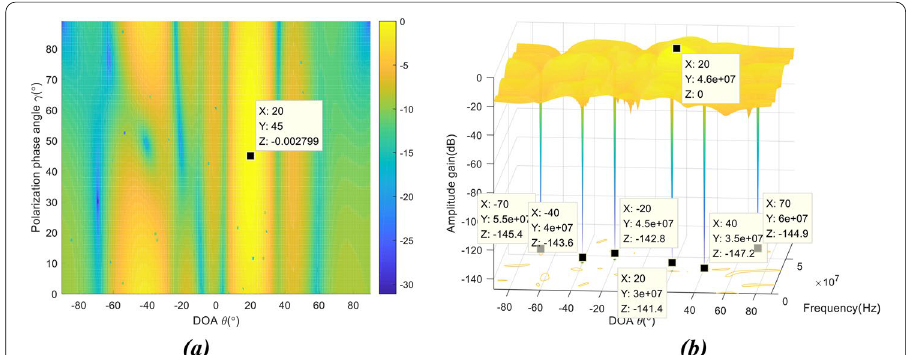
Fig. 7 Three-dimensional beam pattern for the APSA-STPAP algorithm a space-polarization domain null pattern and b top view of the space–time domain null pattern